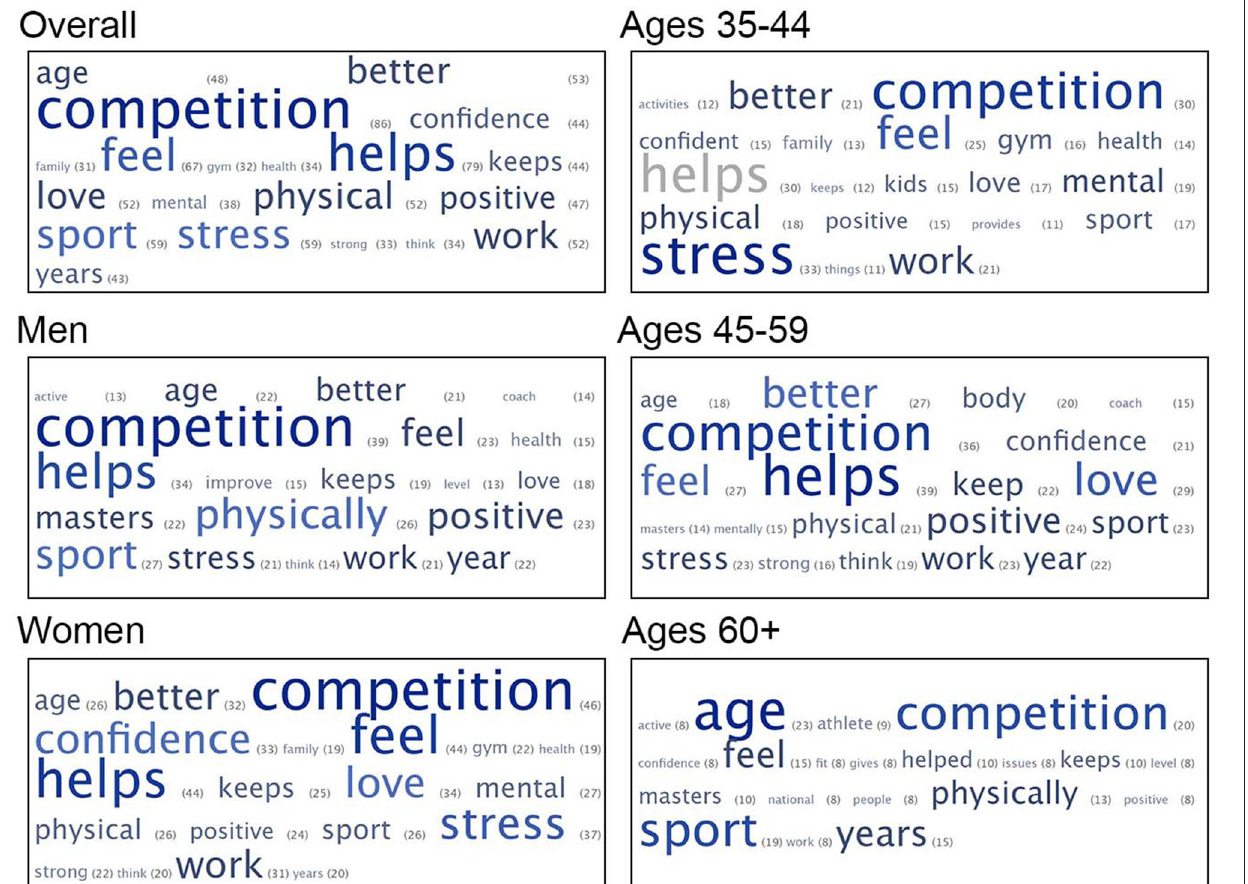
FIGURE 4 | Word clouds showing relative frequency of individual words in participants’ comments (counts in parentheses). More frequent words are